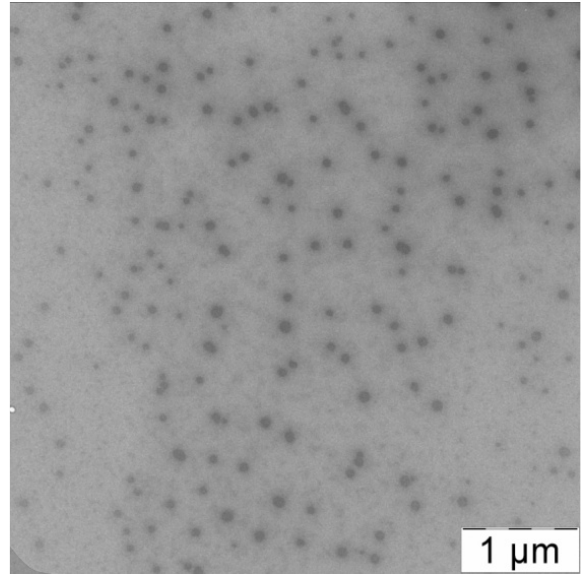
Figure 6. TEM image of PLAMs–us.